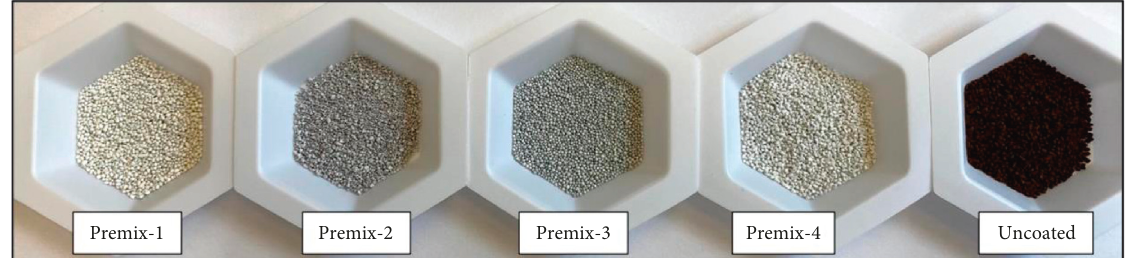
Figure 1: Indian premixes 1–3, UofT positive control 4, and uncoated ferrous